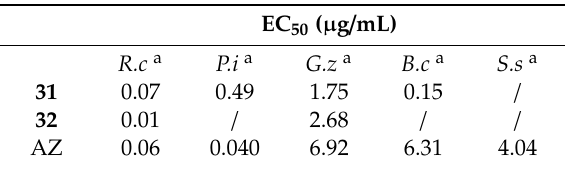
Table 4. EC 50 value of compounds 31 and 32 from References